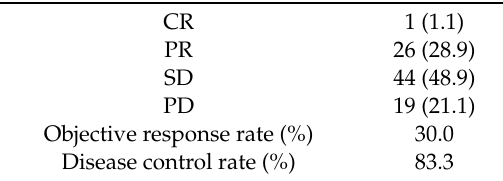
Table 2. Assessment of tumor response ( n = 90).